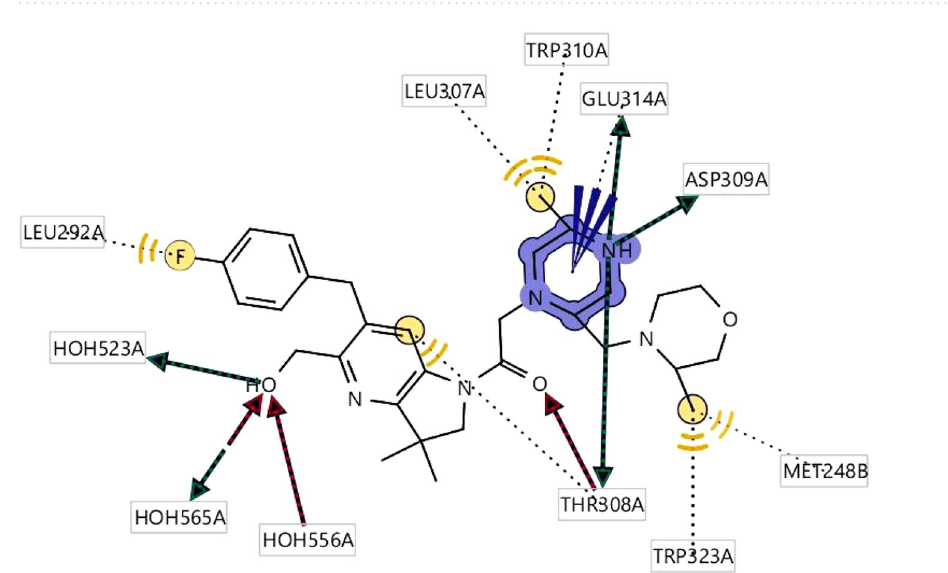
Figure 2. 2D structure obtained during the pharmacophore modeling showing the hydrophobic interaction depicting yellow color and the interaction with the amino acid residues in our selected XIAP protein. Hydrogen bond donor (HBD) features most frequently participated in ligand–protein interaction were shown in green color, whereas the red color showing the interaction of Hydrogen bond acceptors (HBA) to the oxygen, nitrogen atom of the benzine ring and its different side chains. Hydrogen atoms as well as restricted area maintain the shape and position of the binding pocket did not mention in the